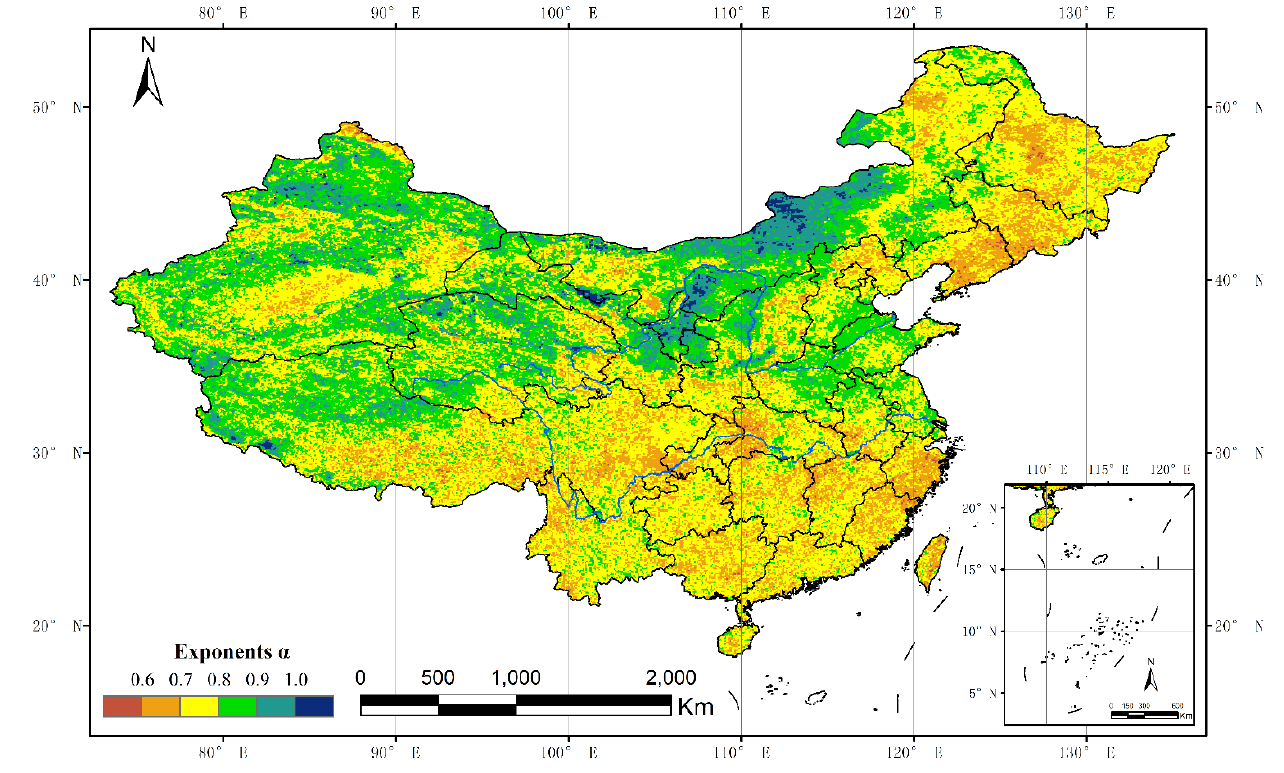
Figure 5. Spatial patterns of the exponent α for the GIMMS NDVI time series calculated via DFA for all of